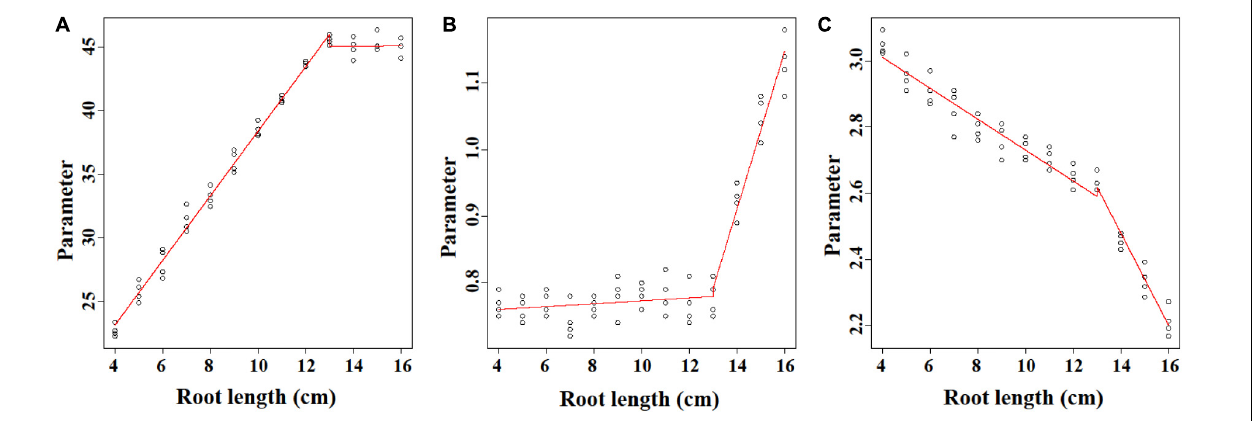
FIGURE 5 | The linear regression analysis of the parameters (A–C) of the Ti-Gompertz model with the root length. The model was characterized by two phases with root lengths ≤ 13 cm and ≥ 13 cm. The values of the parameters were obtained by fitting the aerenchyma percentage of each root length with the Ti-Gompertz model. The experiment was replicated four times ( n = 4). The preview() function in the nlstools package in R was used to plot the graph.